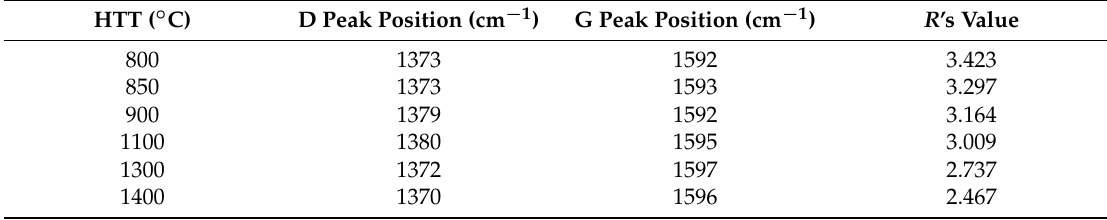
Table 5. Results obtained from fitting analysis for the Raman